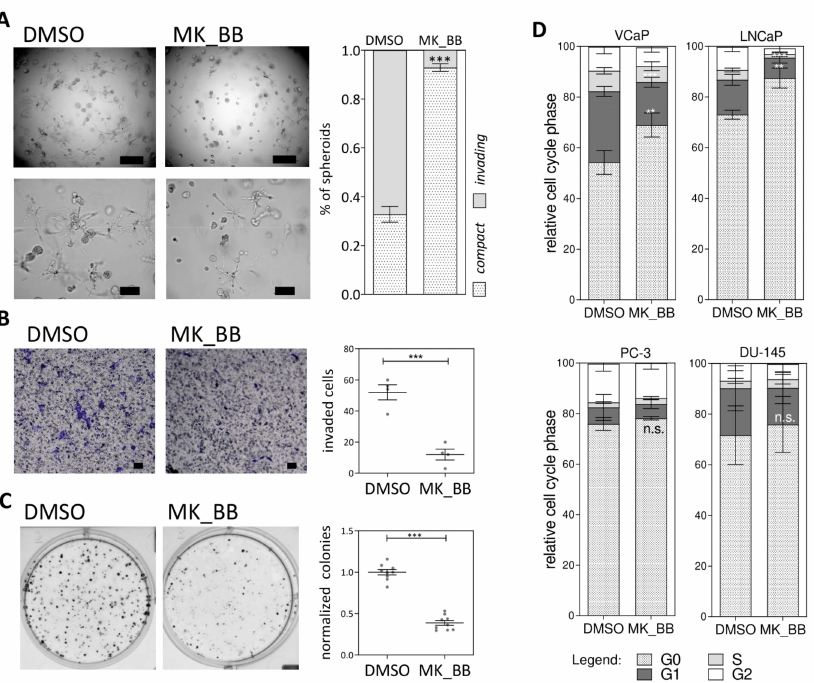
Figure 4. NOTCH signaling enhances PCa cell migration and invasion in vitro. ( A ) 3D invasion assay of PC-3 spheroids. PC-3 cell spheroids in DMSO control, and MK-0752 (MK) Batimastat (BB)-treated conditions. Quantitation of invaded spheroids was performed in three replicates in three randomly selected fields. Scale bars indicate 500 µ m ( top ) or 200 µ m ( bottom ) of length. Stacked bar plots visualize quantitated compact and invading PC-3 spheroids. ( B ) LNCaP migration assay with LNCaP cells. The scale bar indicates 200 µ m of length. Quantitation of migrated cells was performed after crystal violet staining in four randomly selected fields. ( C ) LNCaP colony formation assay. The number of colonies was determined for three biological and technical replicates using the OpenCFU software. ( D ) Cell cycle assay of VCaP, LNCaP, PC-3 and DU-145 cell lines upon NOTCH inhibition (n.s. not significant, ** p ≤ 0.01; *** p ≤